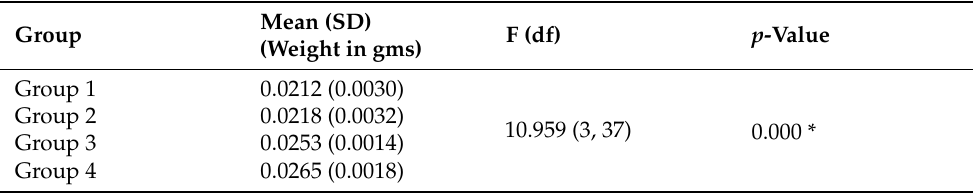
Table 6. Comparative evaluation of solubility of all